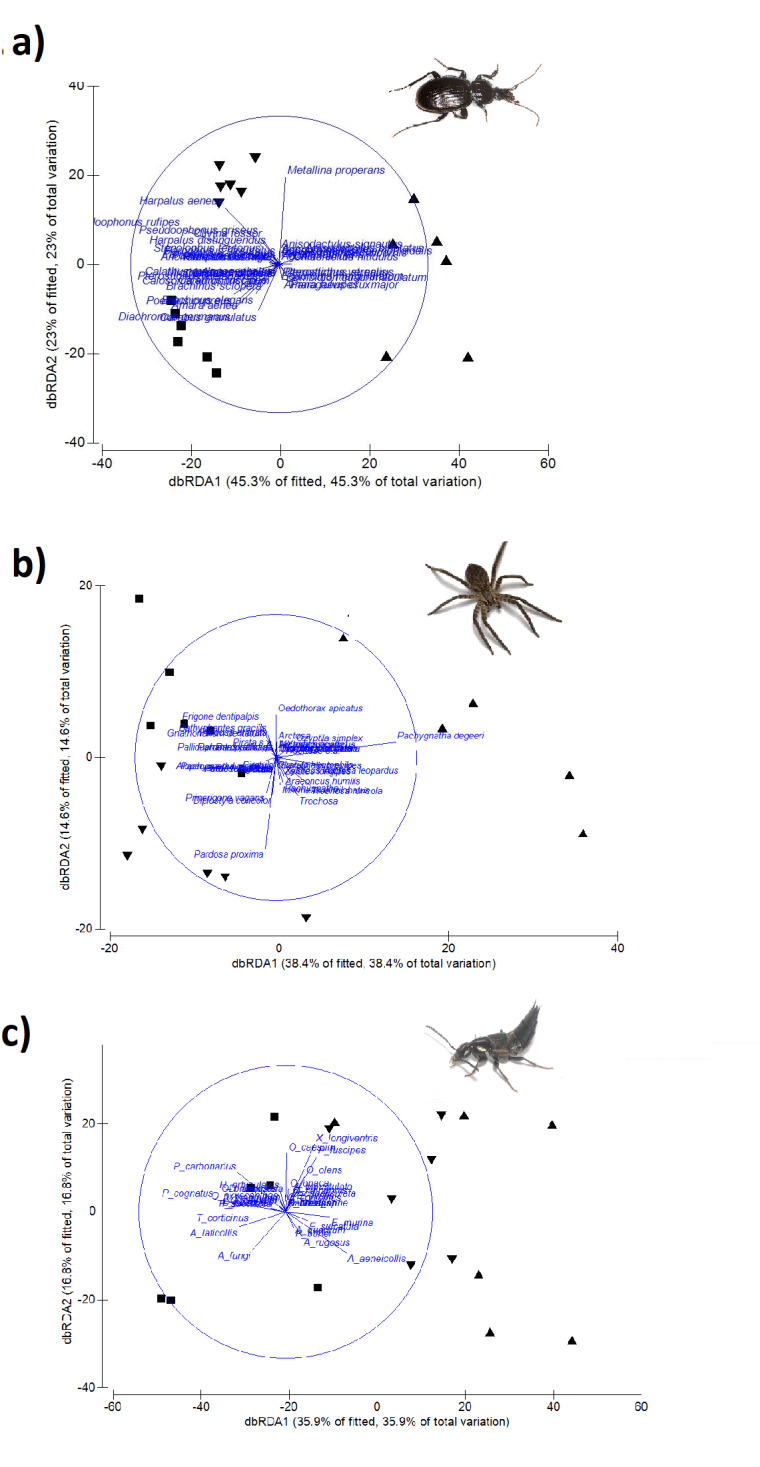
Distance-based redundancy analysis (dbRDA) ordination plot of ground beetle, spiders and rove beetle assemblages in the three marcita fields (Casterno: triangle; Tre Colombaie: inverted triangle; Sforzesca: square)